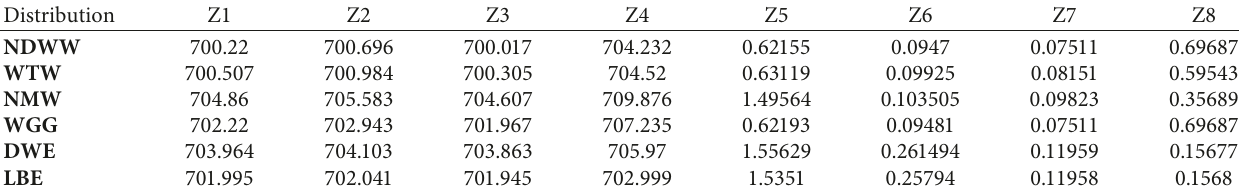
Table 7: Numerical values of Z1, Z2, Z3, Z4, Z5, Z6, Z7, and Z8 for the dataset (1) COVID-19.